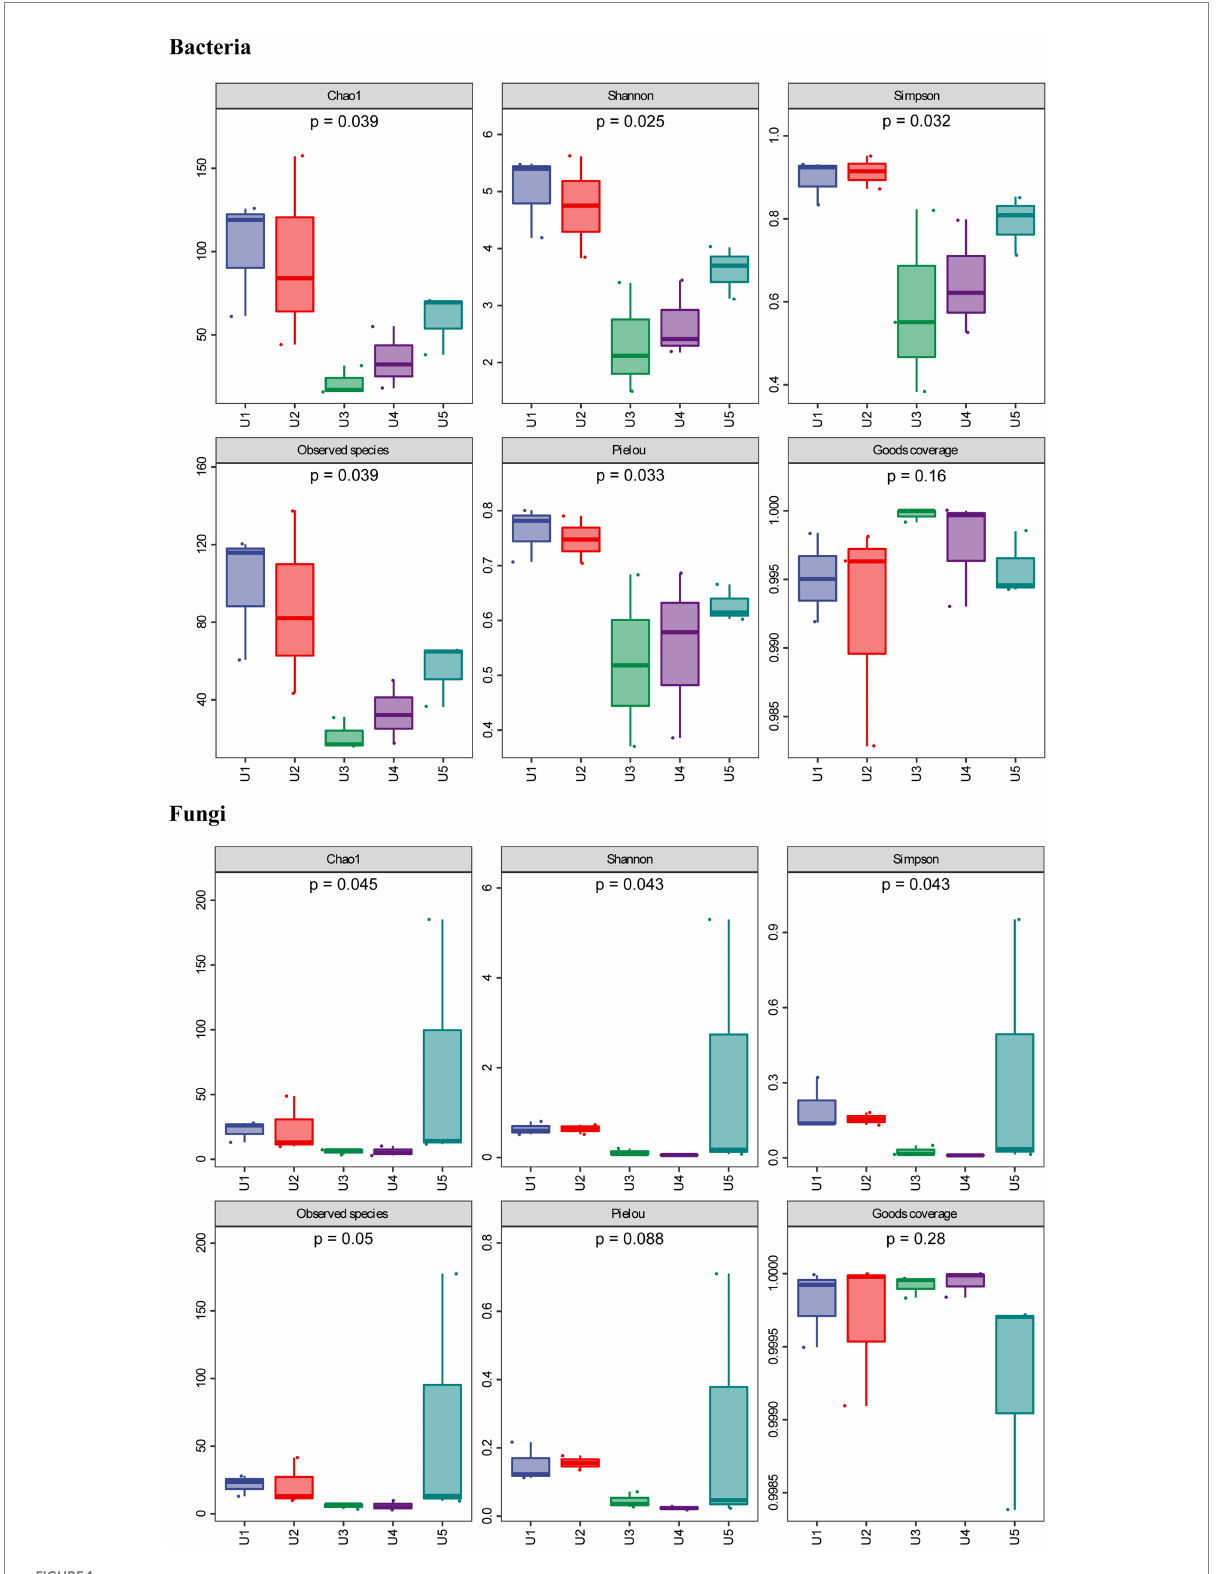
FIGURE 1 Alpha diversity of bacterial and fungal communities associated with Usnea longissima . The samples were collected from five different altitudes. The value of Chao1 (species richness), Simpson (species diversity), Shannon (species diversity), and Pielou (species evenness) index were counted. Observed species and Goods coverage were also calculated and presented. The number under the diversity index label was the p -value of the Kruskal—Wallis